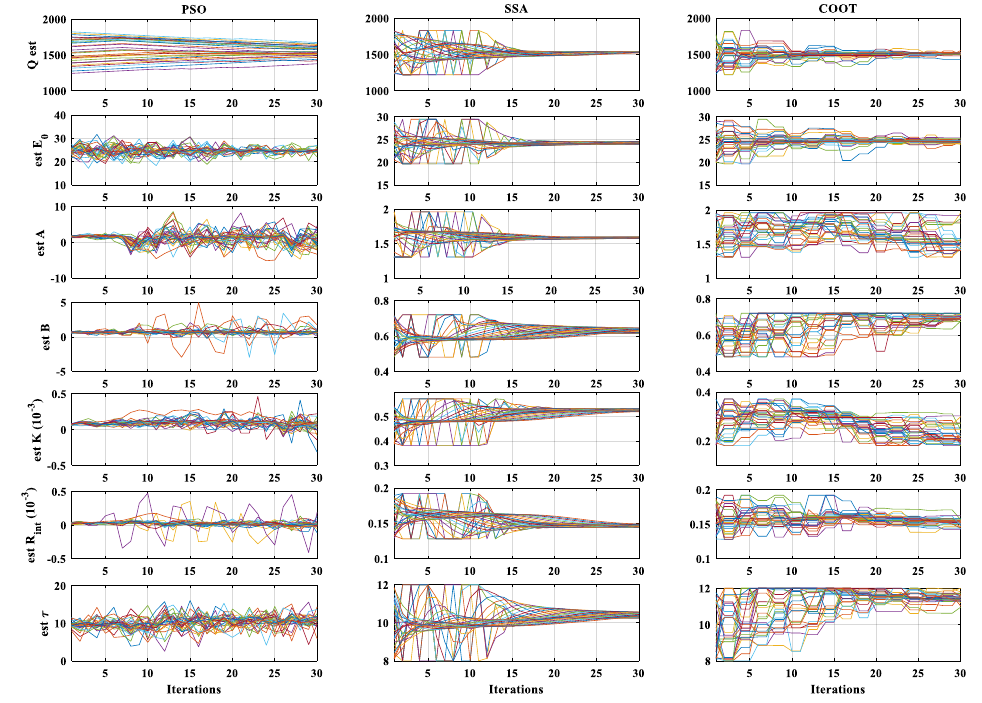
Figure 4. The evolution of PSO, SSA, and COOT during the optimization process. Batteries 2022 , 8 , x FOR PEER REVIEW